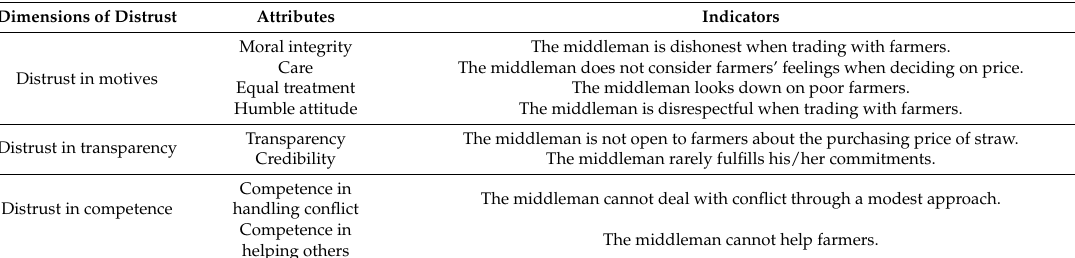
Table 3. Key dimensions and indicators of distrust.